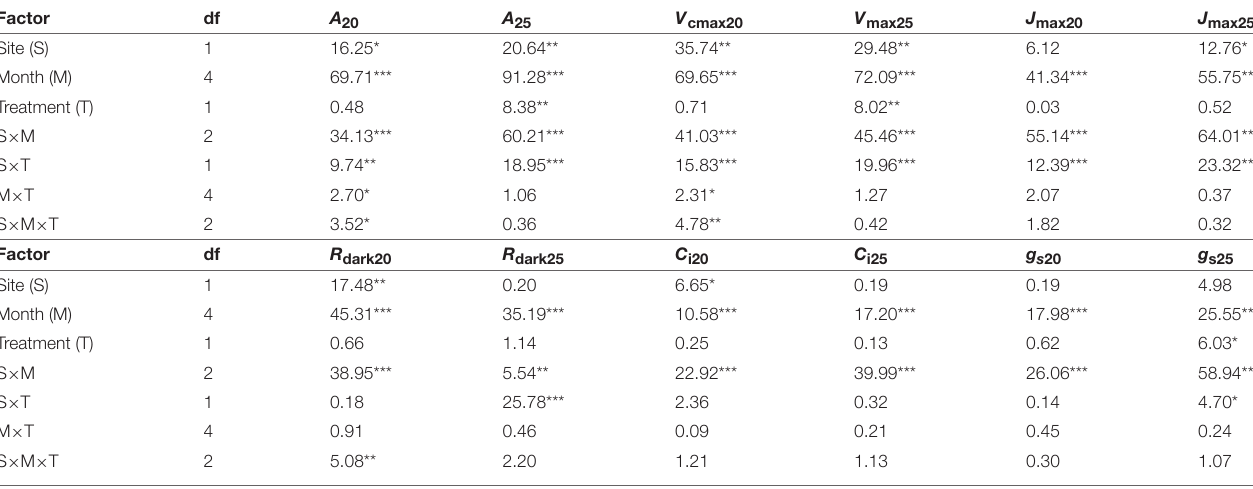
TABLE 2 | Summary of three-way analysis of deviance for the effects of latitude, month, warming treatment and their interactions on leaf characteristics. Factor